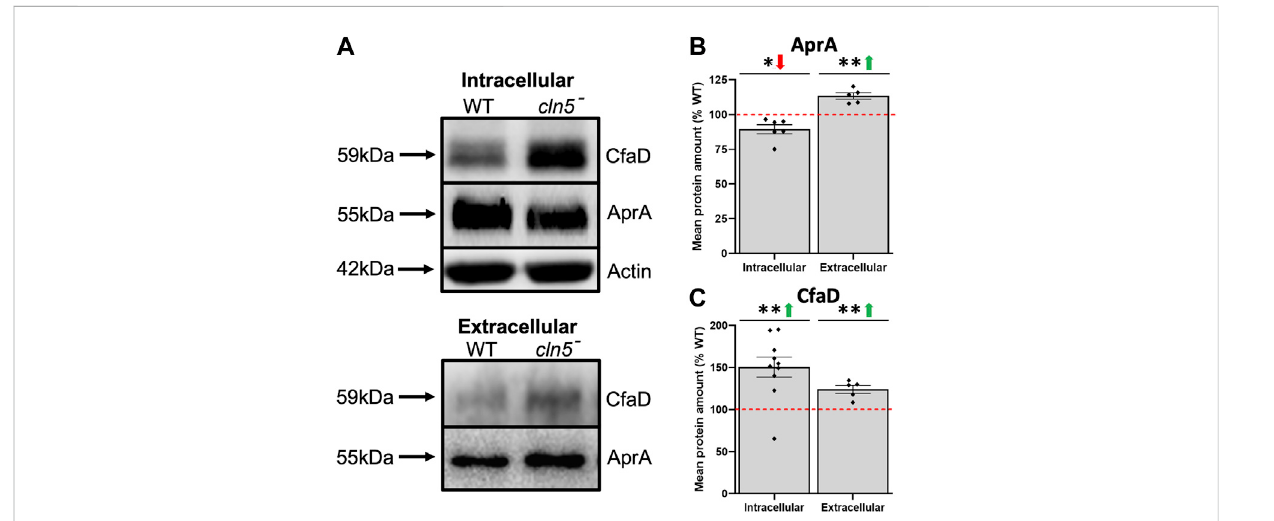
FIGURE 2 Loss of cln5 affects theintracellular and extracellular levels of AprA and CfaD during growth. Whole cell (WC)lysates (20-30 µg) and samples of conditioned media (CM) (0.1 – 0.375 µg) from growth-phase WT and cln5 - cells were separated by SDS-PAGE and analyzed by western blotting. (A) Membranes were probed with anti-AprA, anti-CfaD, and anti- β -actin (loading control). Intracellular and extracellular amounts of (B) AprA and (C) CfaD were quanti fi ed using Fiji/ImageJ and intracellular values were standardized against the levels of β -actin. Data presented as mean protein amount (% WT) ± SEM ( n ≥ 5). * p < 0.05 (one sample t